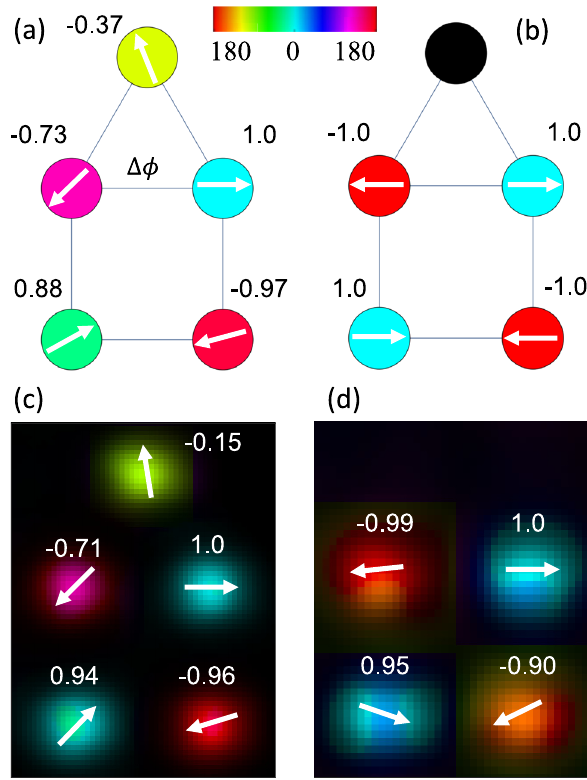
Figure 1: (a) The calculated anti-ferromagnetic XY model ground state on the house graph. (b) The calculated laser network minimal loss state on the house graph (slightly above the oscillation threshold). (c) A measured laser network state with adjusted loss values to achieve equal oscillation amplitudes is in good agreement with the calculated state shown in (a). The (weak) coupling strength is κ ≈ 0 . 05 α 0 and the pump is P − P th ≈ κ . (d) A measured minimal loss state of a network of identical laser oscillators is in good agreement with the calculated state shown in (b). The (strong) coupling strength is κ ≈ 0 . 4 α 0 and the pump value is slightly above the network oscillation threshold ( P − P th ≈ κ / 4). Arrow direction and color hue depict phase values according to color bar. The color brightness depicts the laser amplitude where black corresponding to zero. The phase cosine is written explicitly for each laser oscillator.